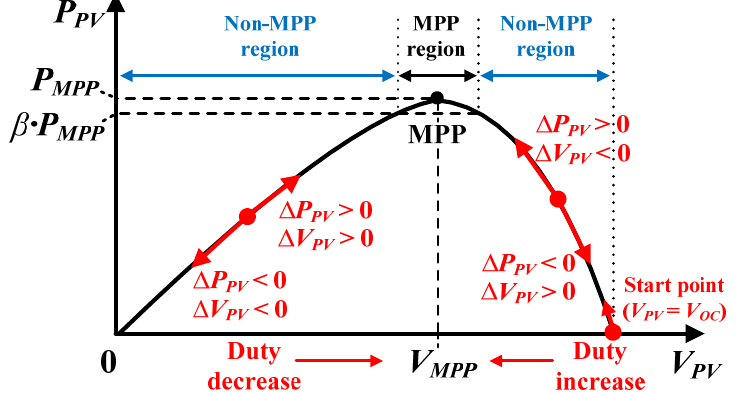
Figure 9. Principle of operation for the proposed MPPT algorithm.